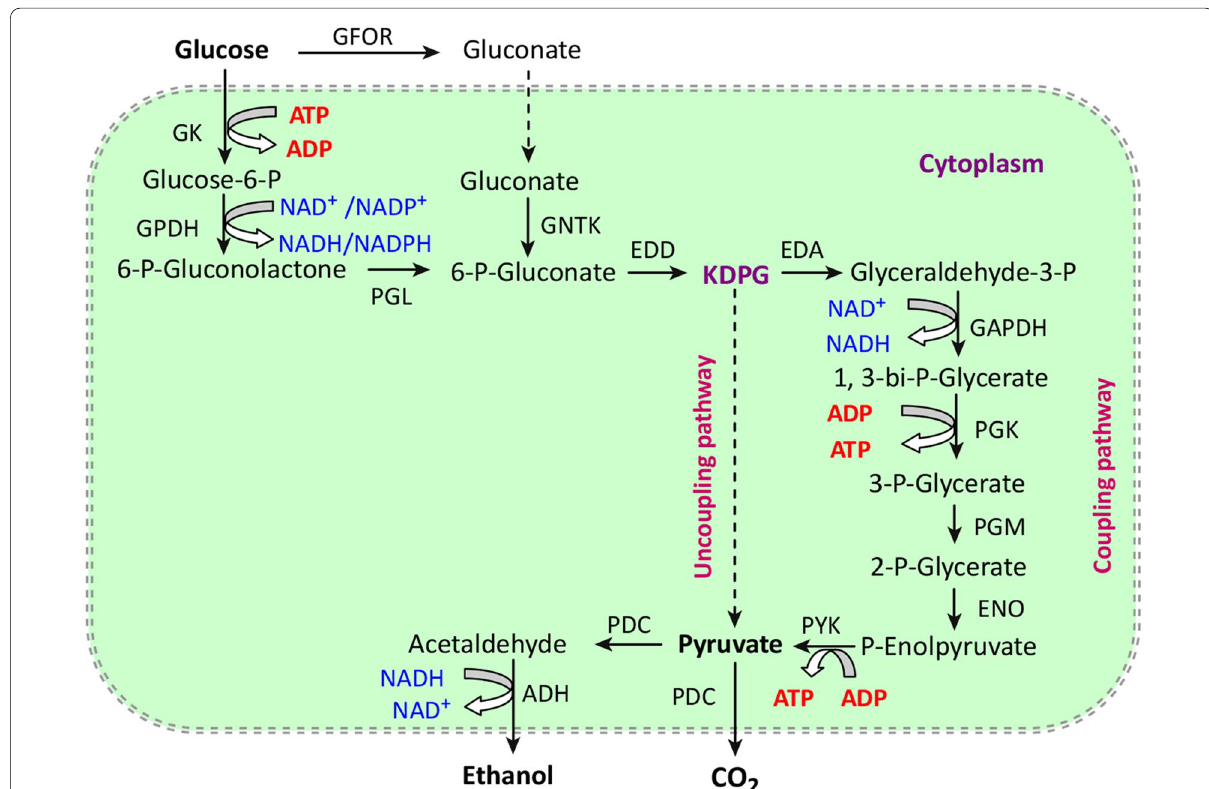
Fig. 4 Entner–Doudoroff (ED) pathway for ethanol fermentation in Z. mobilis . ADH alcohol dehydrogenase; EDA 2-keto-3-deoxy-gluconate aldolase; EDD 6-phosphogluconate (Xia et al.